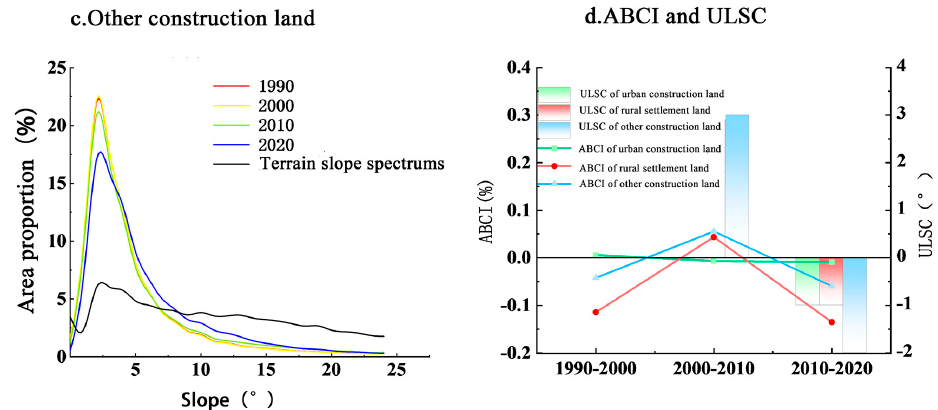
Figure 10. Terrain and construction land slope spectra and ABCI and ULSC values in the LXUA from 1990 to 2020.